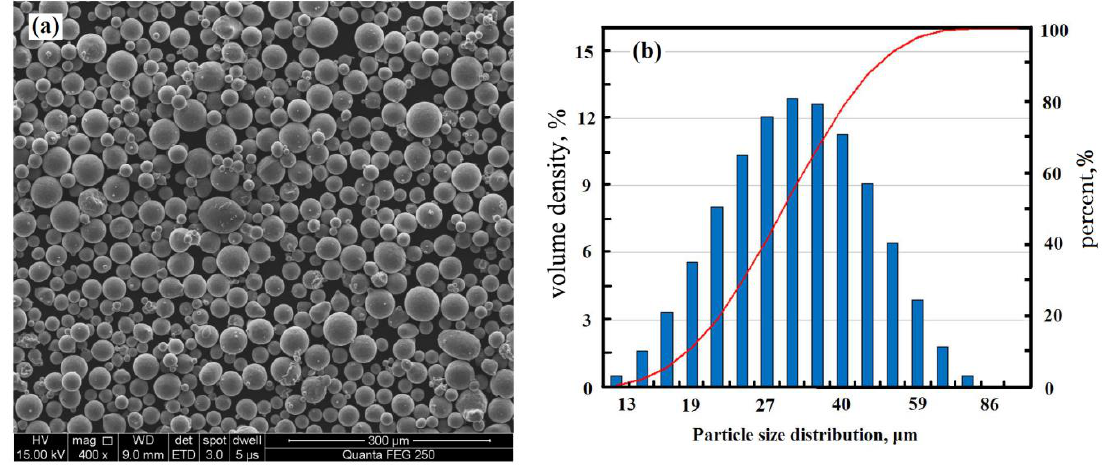
Figure 1. ( a ) SEM images of the powders and ( b ) the corresponding particle size distribution. Table 1. The main chemical compositions of the powder used in selective laser melting (SLM) determined by inductively coupled plasma-atomic emission spectrometry. Element (wt.%)